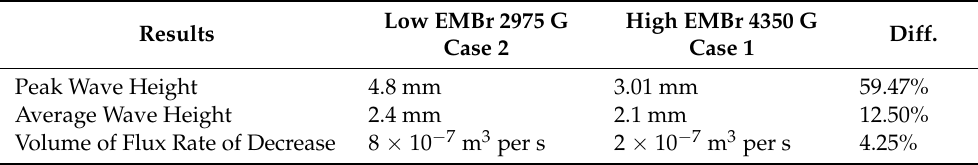
Figure 11. High EMBr strength (Case 1) vs. low EMBr strength (Case 2) flux volume comparison. Table 3. Comparison of cases with high and low EMBr, namely Cases 1 and 2.